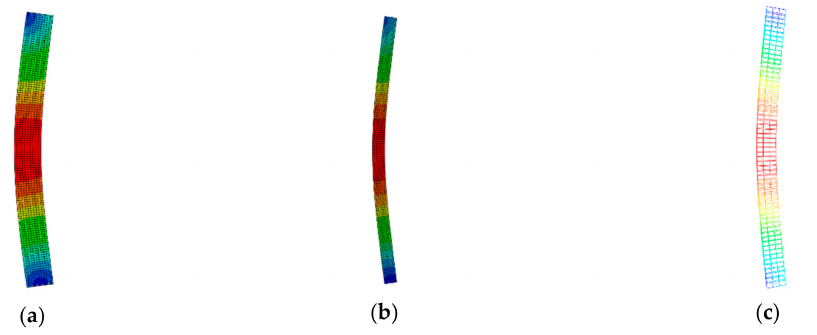
Figure 8. Failure mode ( a ) The overall damage form; ( b ) CFST; ( c ) Steel reinforcement